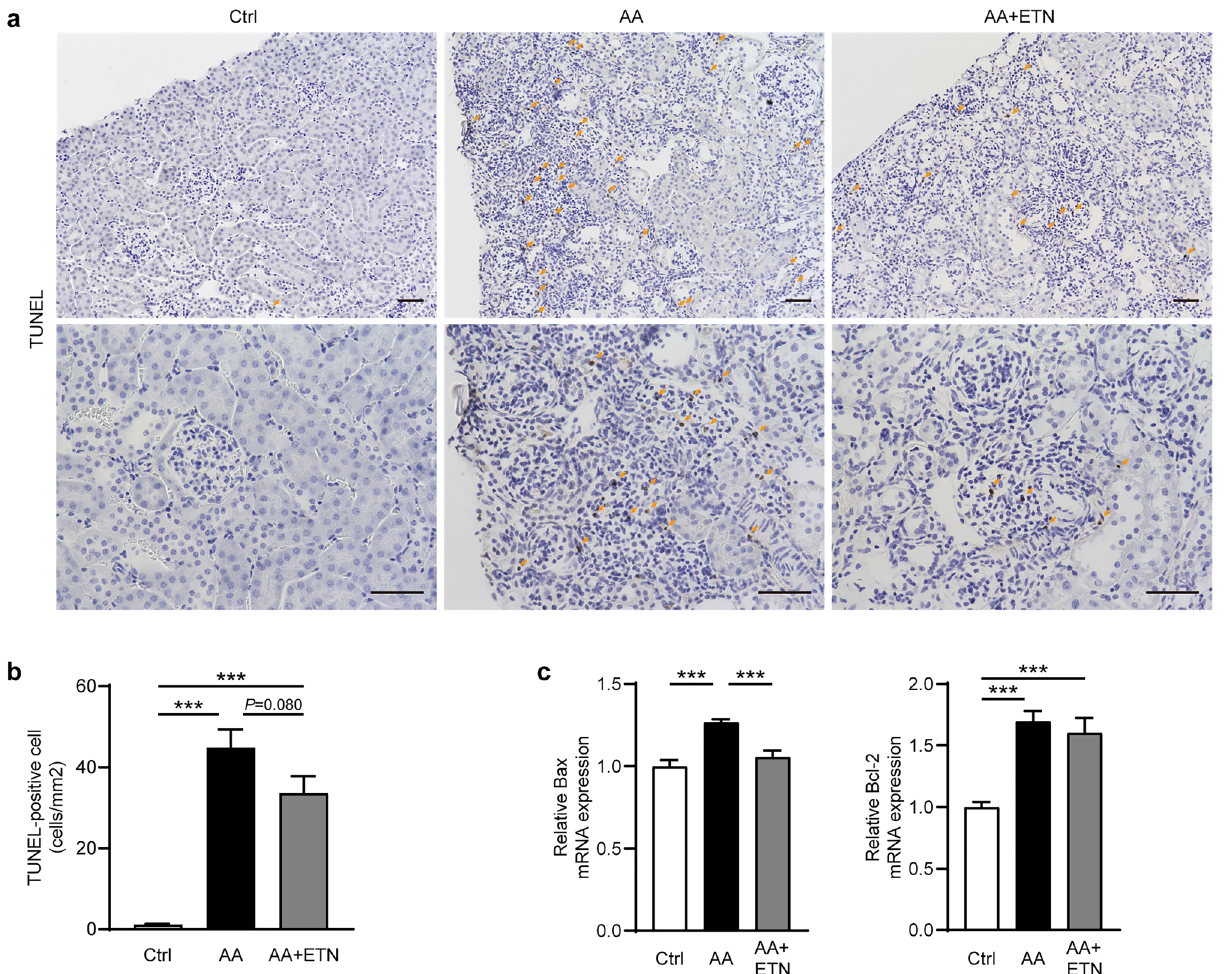
Figure 5. Effect of etanercept on apoptosis. ( a ) Representative images of TUNEL-stained kidneys (upper panel, original magnification, × 200, bar, 50 μm; lower panel, original magnification, × 400, bar, 50 μm). ( b ) Analysis of the number of TUNEL-positive cells. ( n = 7–8). ( c ) Relative renal mRNA expression of Bax and Bcl-2 ( n = 7–8). Values are means ± SEM. *** P < 0.001. Ctrl, control; AA, aristolochic acid; ETN, etanercept; TUNEL, TdT- mediated dUTP nick-end